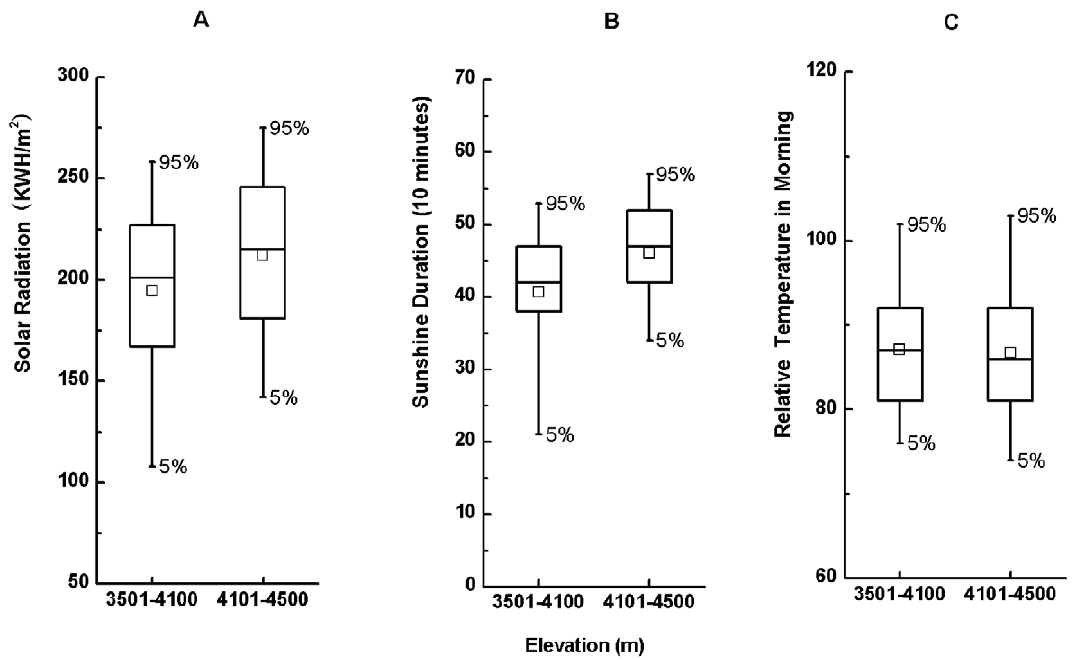
Figure 2. Mean radiation (A) and duration (B) of sunlight, and relative temperature (C) across the winter range (4101–4500 m) and non-winter range (3500–4100 m). Horizontal lines represent medians and quartiles; boxes represent means.